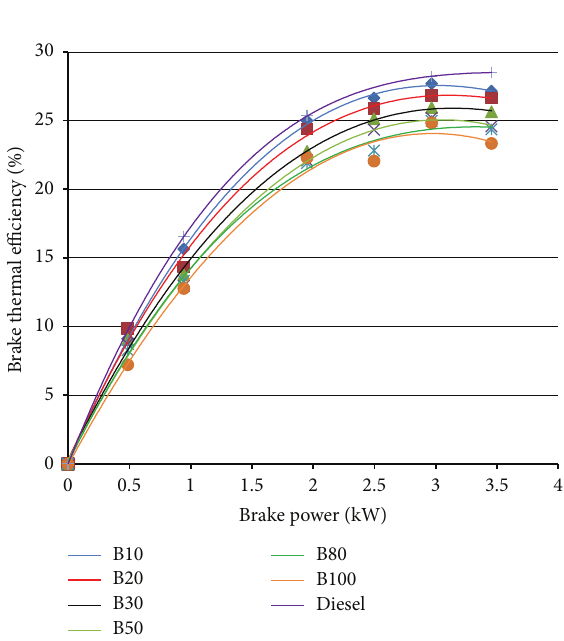
Figure 5: Brake thermal efficiency versus brake